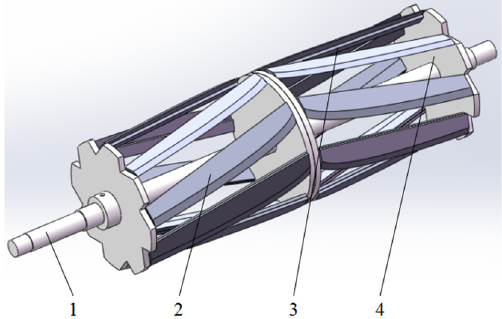
Figure 1. Flat hob chopper: 1. knife roller shaft; 2. blade; 3. knife holder; and 4. blade fixing plate.